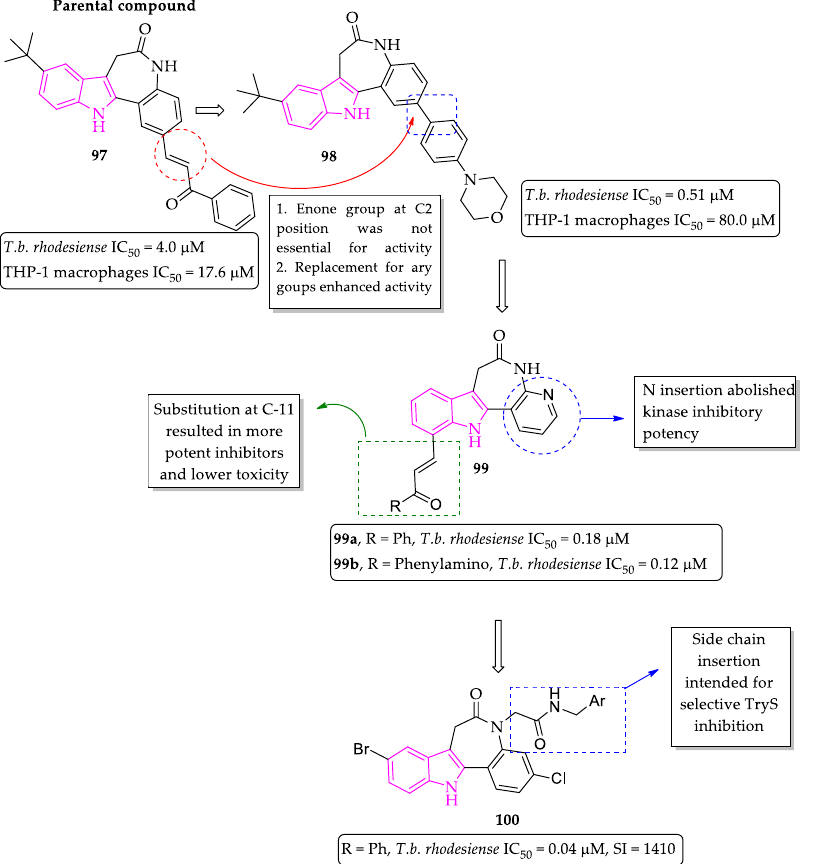
Figure 14. Paullone scaffold optimization.